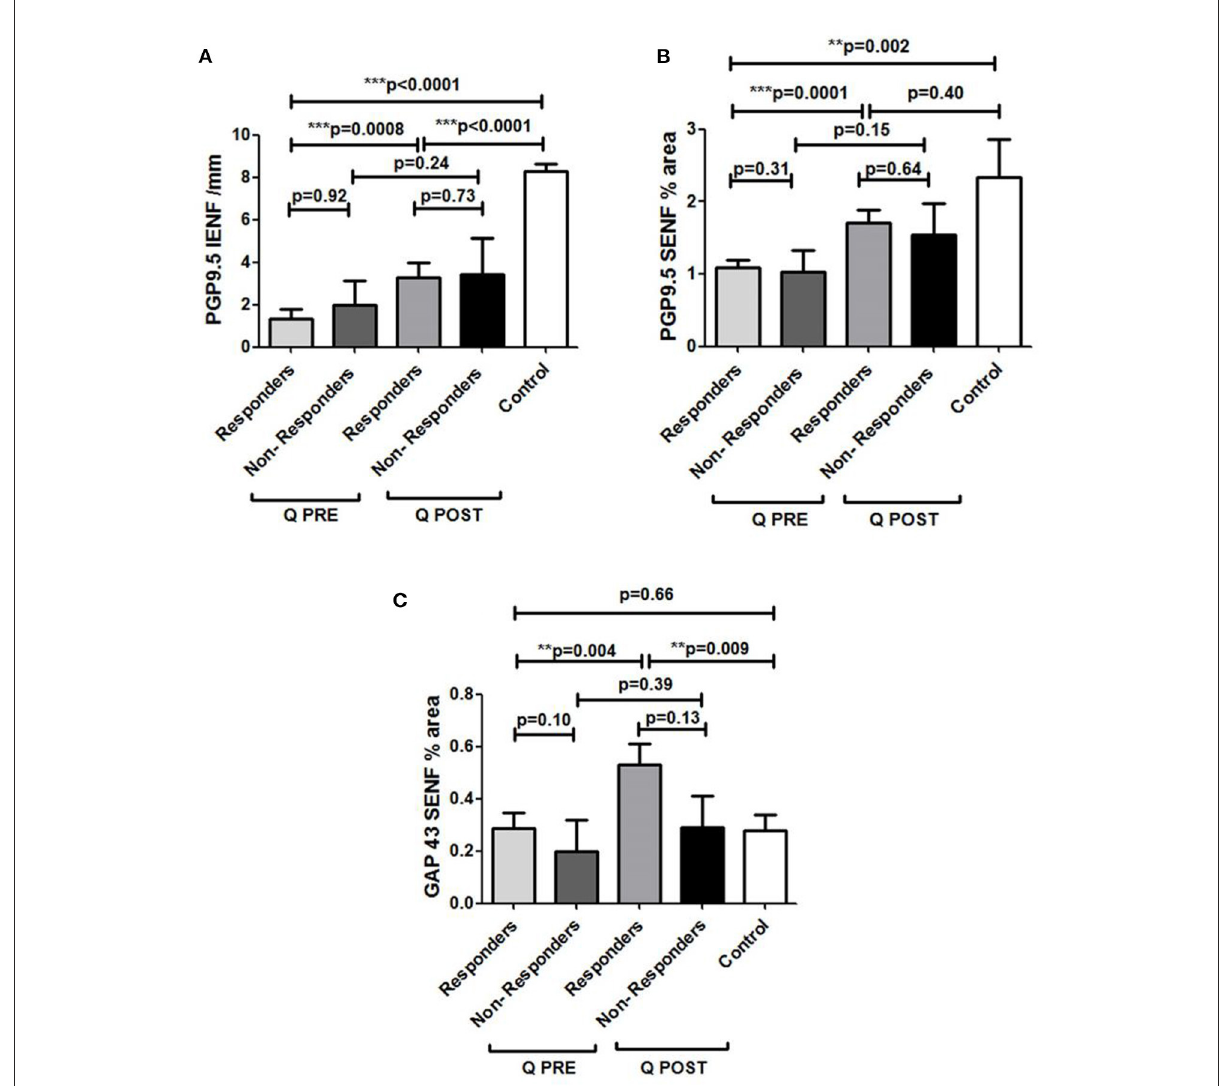
FIGURE12 Assessment of skin biopsy in relation to pain relief in Painful Diabetic Peripheral Neuropathy subjects treated with Capsaicin 8% patch. (A) Assessment of intra–epidermal PGP9.5 nerve fibers (IENFs/mm; 50 µ m sections) in responders ( n = 18) and non–responders ( n = 7) at pre–treatment visit (Q PRE) and visit 3 months after treatment (Q POST). Statistically significant increase in PGP9.5 nerve fibers 3 months after capsaicin 8% patch application in responders (*** p = 0.0008; paired t –test). No statistically significant difference in PGP9.5 nerve fibers 3 months after capsaicin 8% patch application in non–responders’ group ( p = 0.24; paired t –test). (B) Assessment of sub–epidermal PGP9.5 nerve fibers (SENFs, Area %; 50 µ m sections) in responders ( n = 18) and non–responders ( n = 7) at pre–treatment visit (Q PRE) and visit 3 months after treatment (Q POST). Statistically significant increase in PGP9.5 nerve fibers 3 months after capsaicin 8% patch application in responders (*** p = 0.0001; paired t –test). No statistically significant difference in PGP9.5 nerve fibers 3 months after capsaicin 8% patch application in non–responders group ( p = 0.15; paired t –test). (C) Assessment of sub–epidermal GAP 43 nerve fibers (SENFs/mm) in responders ( n = 18) and non–responders ( n = 7) at pre–treatment visit (Q PRE) and visit 3 months after treatment (Q POST). Statistically significant increase in GAP